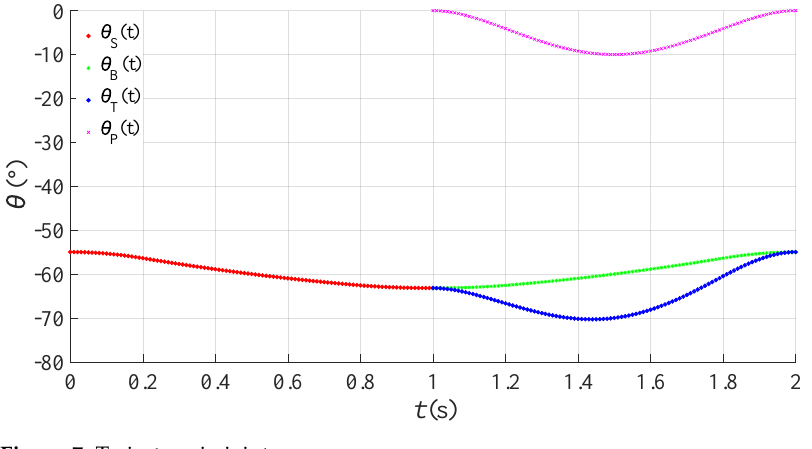
Figure 7. Trajectory in joint-space.